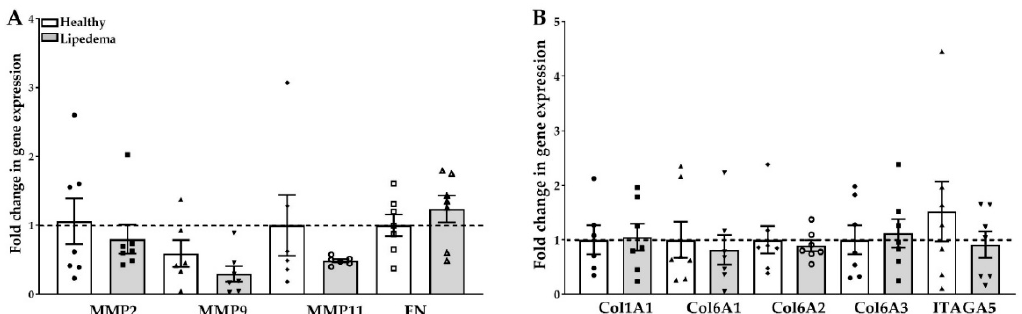
Figure 4. Expression of extracellular matrix (ECM) genes in lipedema- and non-lipedema- differentiated 3D spheroids. The qRT-PCR data showed a similar gene expression of ( A ) MMP-2, 9 and 11 and FN ( n = 7 per group) and ( B ) Col1A1, Col6A1, Col6A2, Col6A3 and ITAGA5 ( n = 7 per group). The gene expression of the differentiated adipocyte spheroids is calculated from the percent of undifferentiated spheroids of each group. The results are displayed as scatter plots with bars. The values are the mean ± SEM. The dotted line represents the expression level normalized to that of the undifferentiated spheroids. Abbreviations: Col: collagen; FN: fibronectin; ITAGA5: integrin A5; MMP: matrix metalloproteinase.